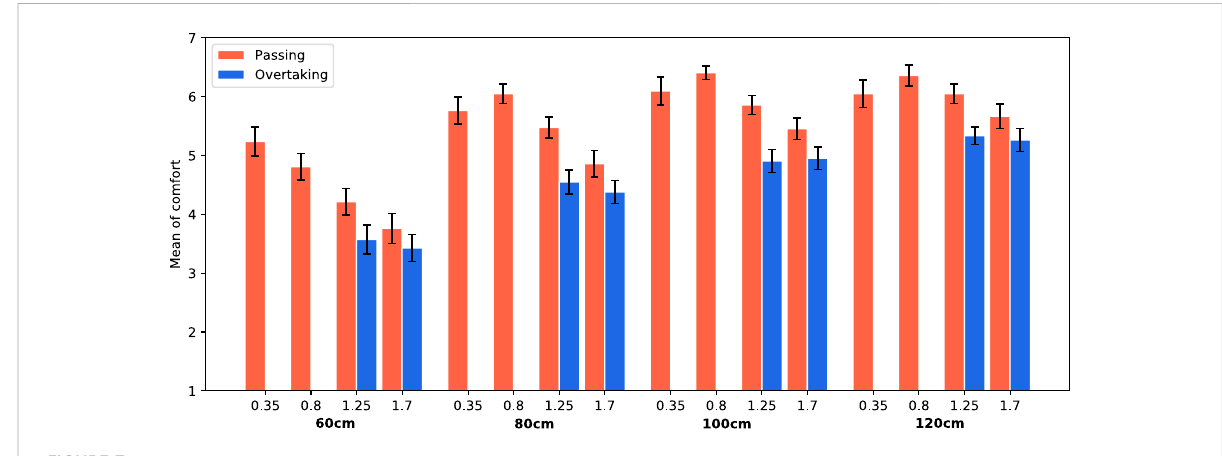
FIGURE 7 Average comfort values for both trials. The passing side (left/right) is averaged. Error bars represent Standard Error.